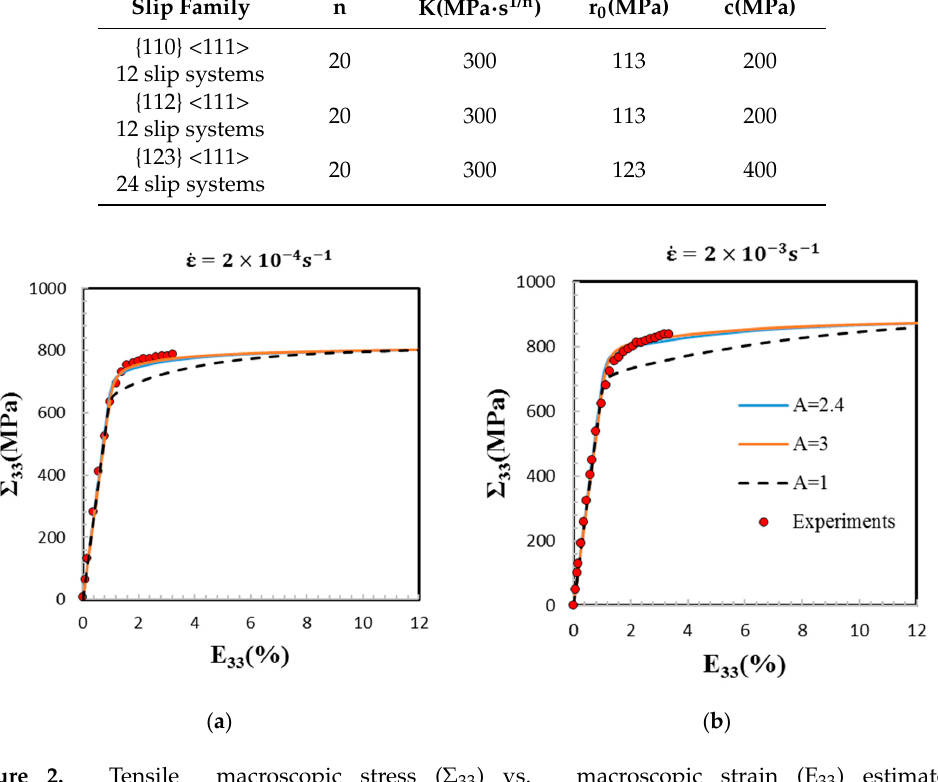
Table 2. Viscoplastic parameters of the β -single crystal for each slip system family. Slip Family (cid:1814)